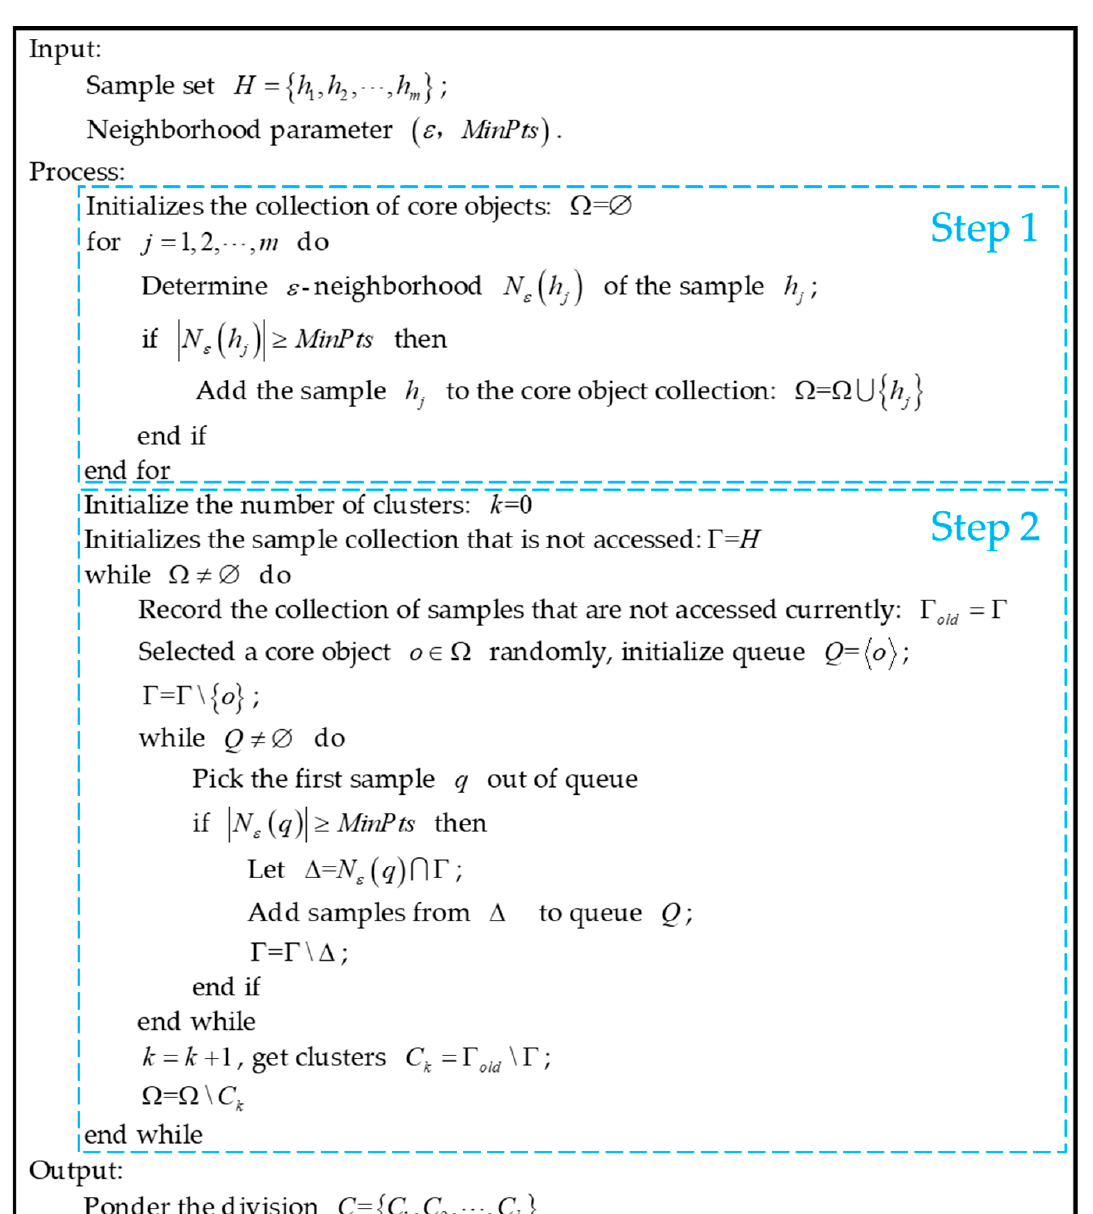
Figure 6. DBSCAN pseudo code flow chart. Based on the above analysis, the sample set H is the DOA estimation result of the small snapshot data, and the neighborhood parameters can also be selected according to the characteristics of the signal data. The selection idea will be discussed in the following